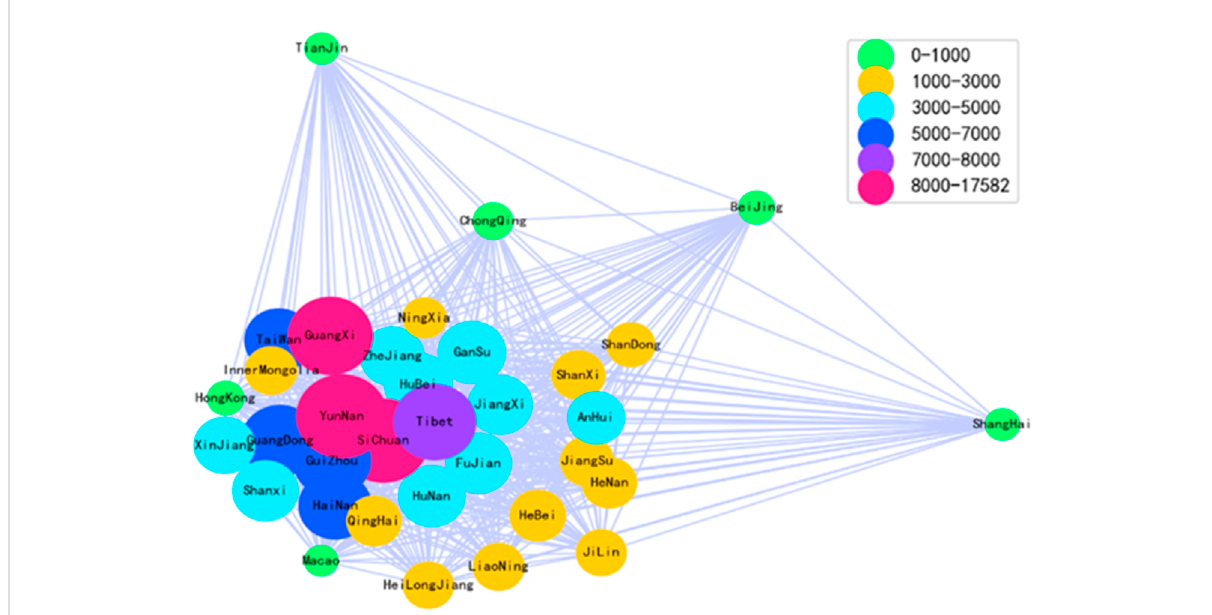
FIGURE 7 A network graph with a node represents a provincial administrative region in China. The node colour represents the range of the number of plant species in each provincial administrative region. The distance between the nodes represents the similarity in plant species between different provincial administrative regions. A closer distance between the two nodes indicates a higher similarity in the plant species between the two provincial administrative regions and vice